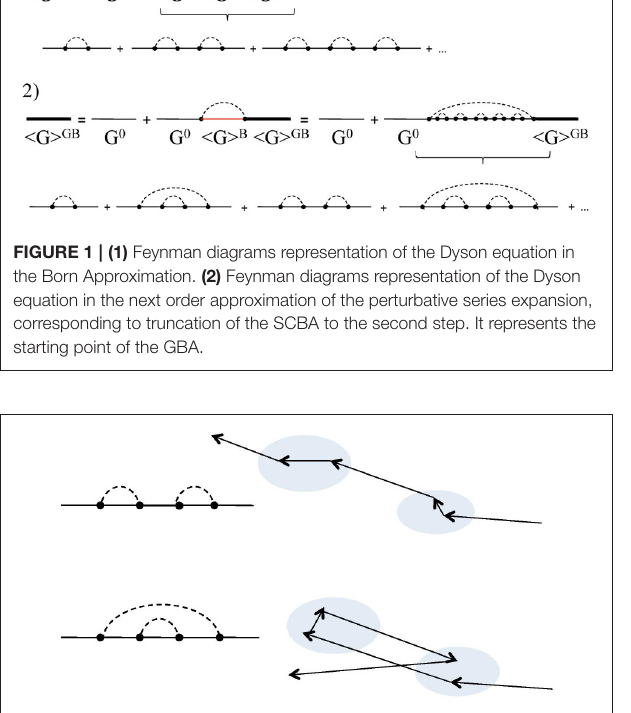
FIGURE 2 | Selection of two Feynman diagrams with the corresponding scattering events. Both the diagrams describe a four-fold scattering. The diagram on the top accounts for double scatterings occuring in the same inhomogeneity, whereas the diagram on the bottom also accounts for a double scattering from two different